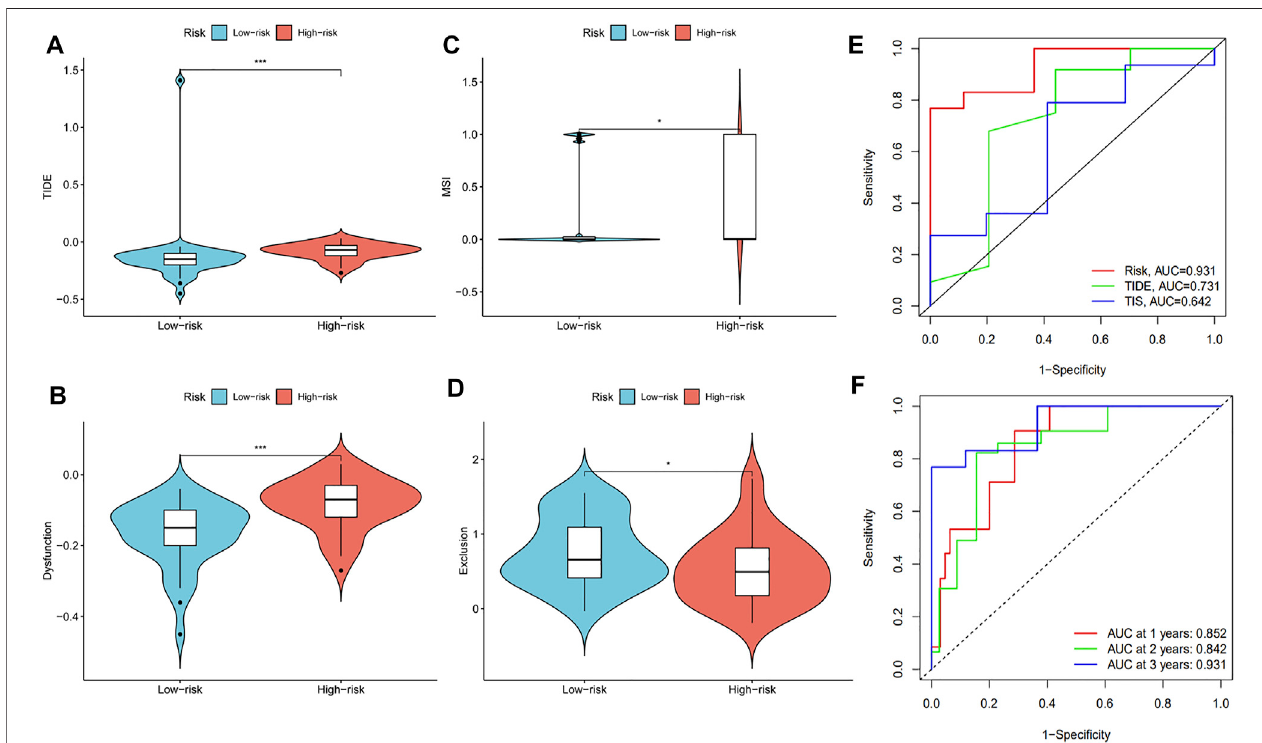
FIGURE 8 | The evaluation of prognostic risk model. The (A) TIDE scores, (B) dysfunction scores, (C) MSI, and (D) exclusion scores were analyzed in the low-risk and high-risk groups of ESCC patients. (E) ROC analysis of the risk model, TIDE scores, and TIS scores. (F) ROC analysis of the 1, 2, and 3-years survival of ESCC